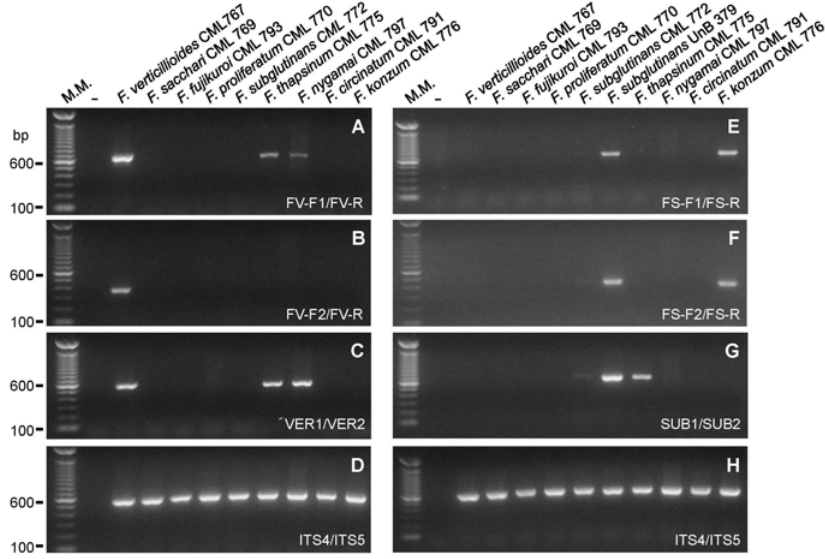
Figure 2. Specificity analysis of the primer pairs FV and FS described in this work and the primer pairs VER1/VER2 and SUB1/SUB2 described by Mulè et al. [14] with the G. fujikuroi species complex isolates genomic DNA. The PCR reactions were analyzed in 1.5% agarose gel stained with ethidium bromide. M.M. indicates the 100-bp molecular marker from Invitrogen (USA). ( − ) indicates the negative control reaction in which no DNA was